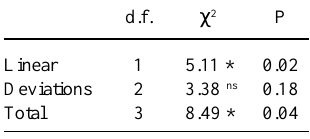
y = -0.05x + 0.27 R 2 =